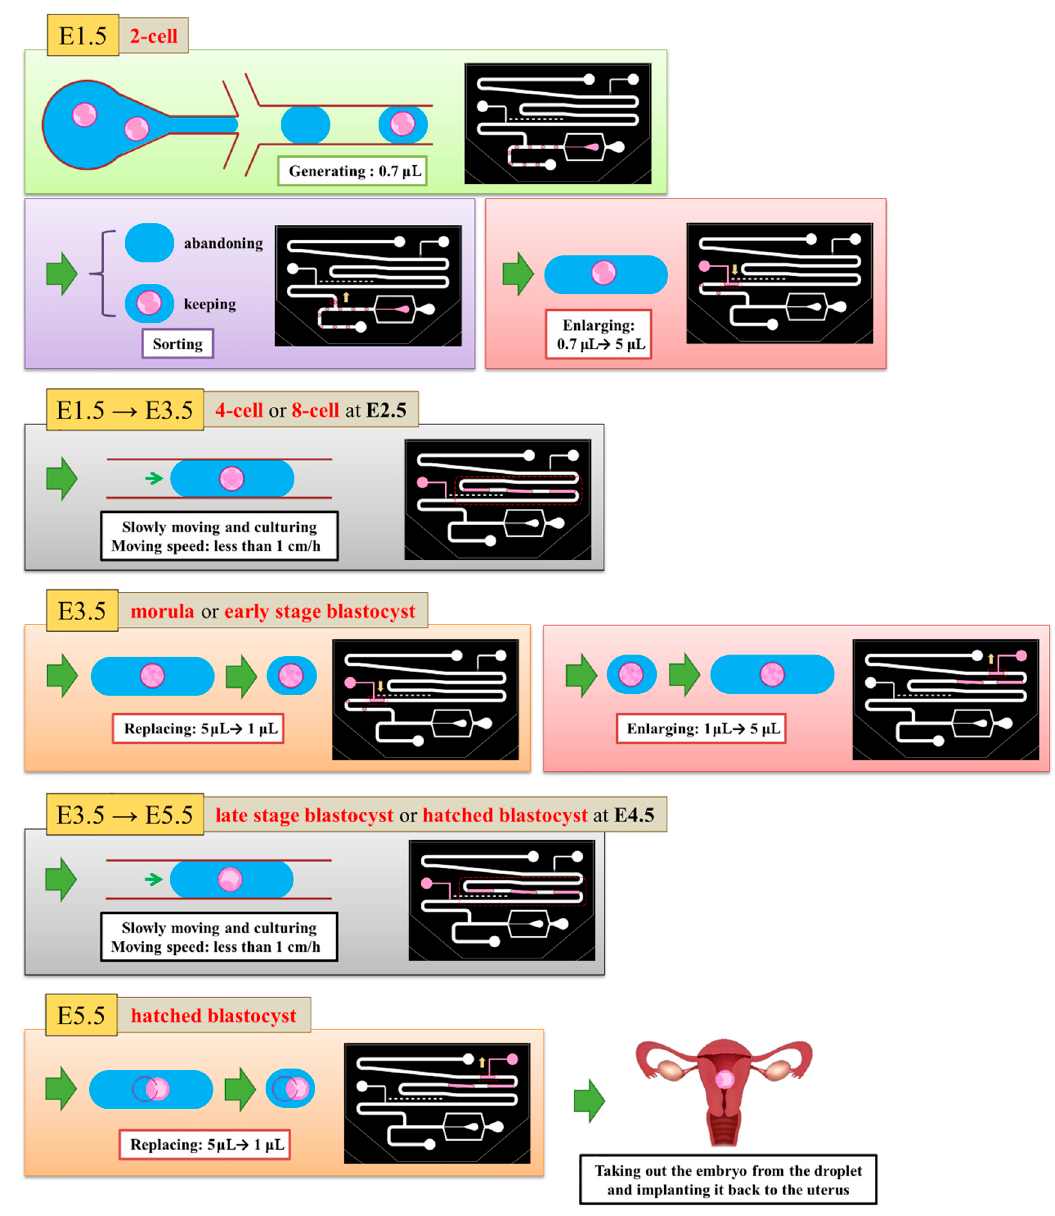
Figure 4. 5.5 days are required to culture an embryo from zygote to hatching. At Day 1.5, we generated 0.7- µ L droplets and retained the droplets with embryos. We enlarged all selected droplets to 5 µ L. From Day 1.5 to Day 3.5, the embryos grew in the 5- µ L droplets. At Day 3.5, we absorbed the liquid from the droplets until the size became 1 µ L. We then enlarged all droplets to 5 µ L. From Day 3.5 to Day 5.5, embryos grew in the 5- µ L droplets again. At Day 3.5, we absorbed the liquid from the droplets until the size attained 1 µ L to finish our experiment.